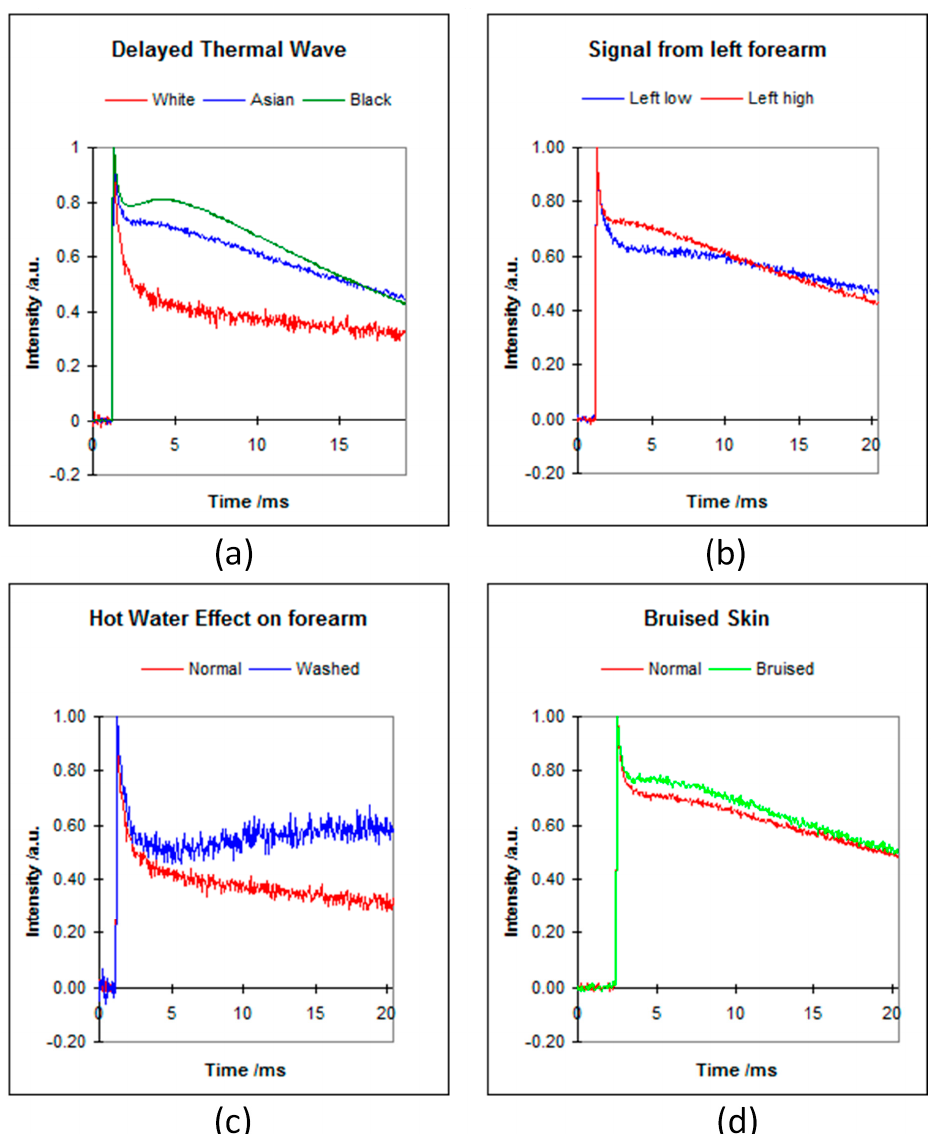
Figure 3. The OTTER signals of different types of skin ( a ); different position on forearm ( b ); hot water effect ( c ); and bruised skin ( d ) [10].